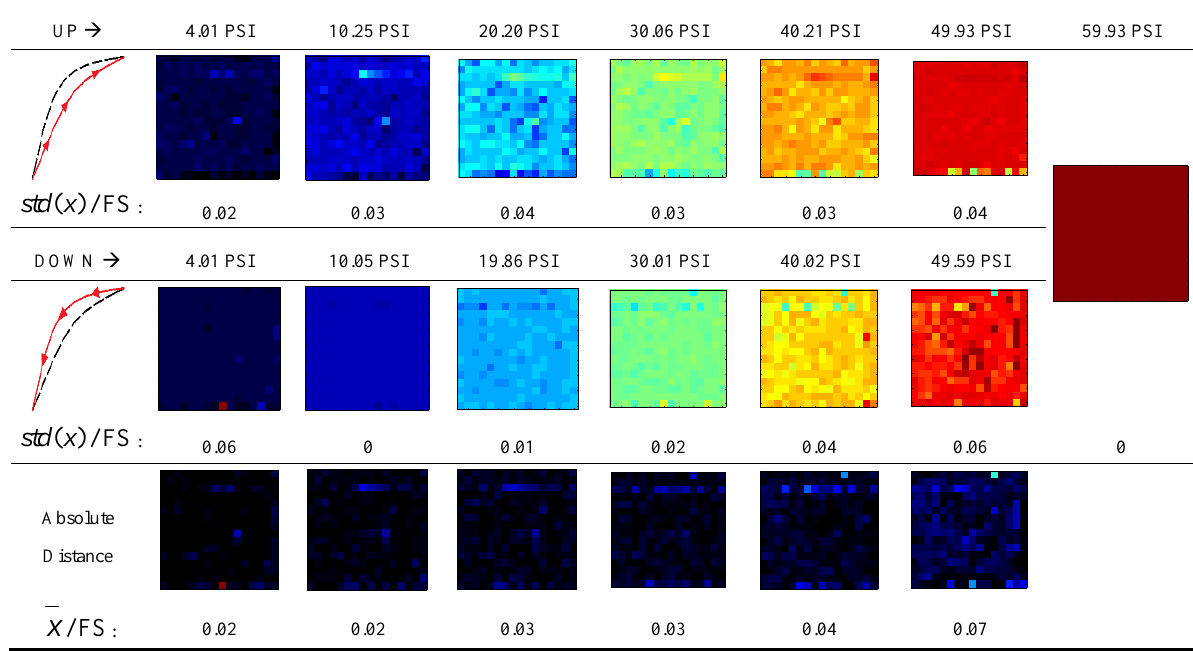
Table 7. Hysteresis loop frames after compensation with ELAM